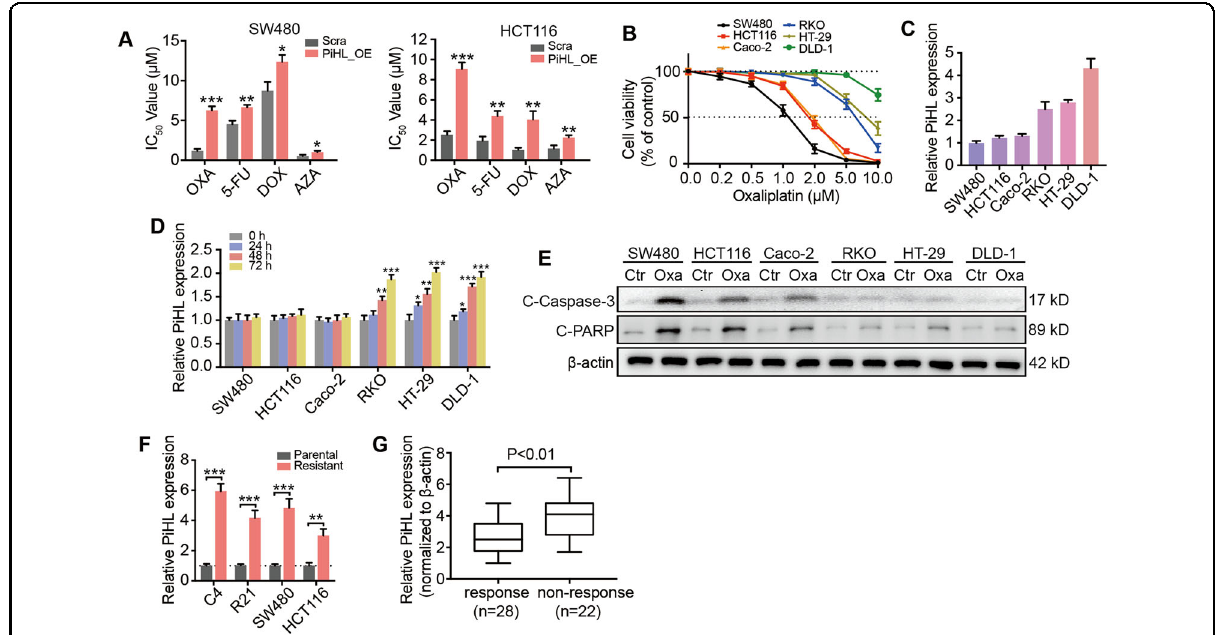
Fig. 1 PiHL is activated in oxaliplatin-resistant CRC. A IC50 values of OXA, 5-FU, DOX, and AZA in SW480 (left) and HCT116 cells (right) under PiHL overexpression (PiHL_OE) or control (Scra) conditions were determined using the CCK-8 assay. B Different CRC cells were treated with increasing concentrations of oxaliplatin for 72 h and exhibit different drug sensitivity. C PiHL levels in different CRC cells analyzed by qRT-PCR. D Expressions of PiHL in CRC cells treated with 5 μ mol/l ( μ M) oxaliplatin for the indicated time. E Immunoblots analyze the expression of cleaved Caspase-3 (C- Caspase-3) and cleaved PARP (C-PARP) after 5 μ M oxaliplatin or control (Ctr) treatment for 72 h. F Expression of PiHL in Oxa-resistant CRC cells and parental cells was analyzed by qRT-PCR. G The expression of PiHL in CRC patients with a response ( n = 28) or no response ( n = 22) to oxaliplatin- based therapy from our cohort, two-tailed Student ’ s t -test. Data are presented as the mean ± SD, * P < 0.05, ** P < 0.01, *** P <